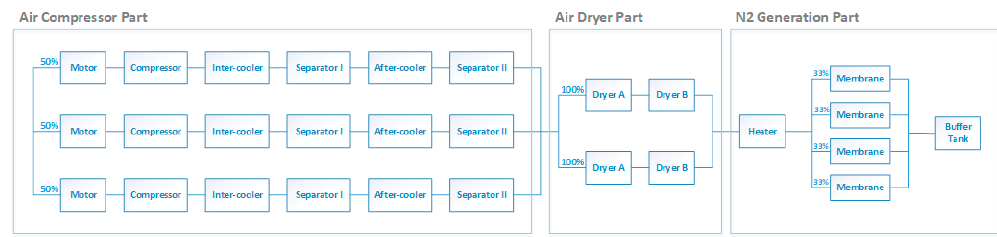
Figure 7. Reliability block diagram at Stage I (PFD stage).